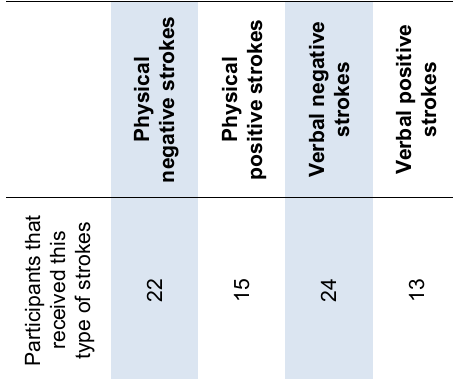
Table 6: Results of Brief Script Questionnaire: Life Positions